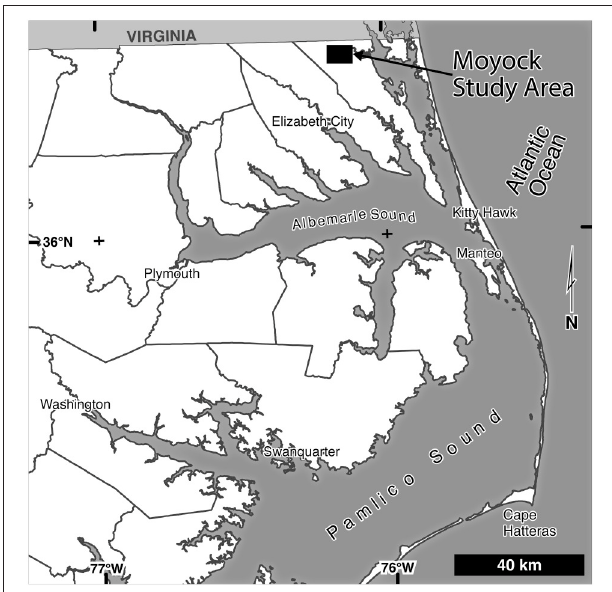
FIGURE 2 | Study area location, Moyock, North Carolina,